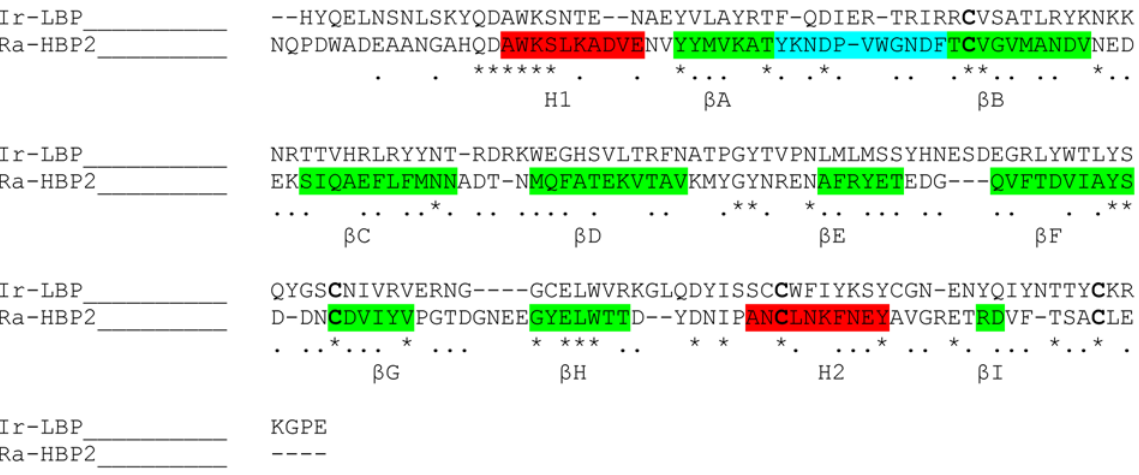
Figure 2. Alignment between Ir-LBP and Ra-HBP2 used as input for Modeler. * stands for an identical residue and N for similar residues. Secondary structure elements ( b A to b I in green and H1, H2 in red; V loop in blue) of Ra-HBP2 are indicated.